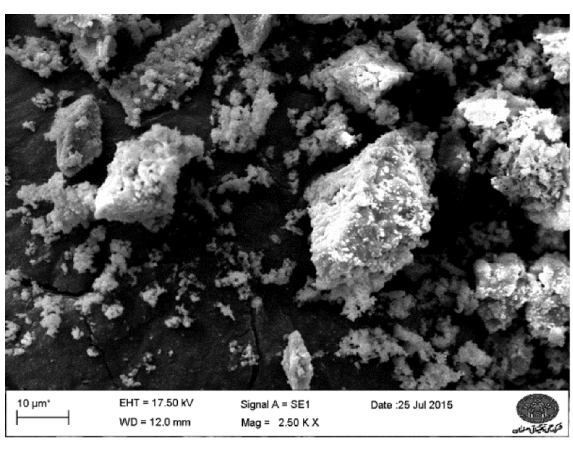
Fig. 4. SEM images of the additives